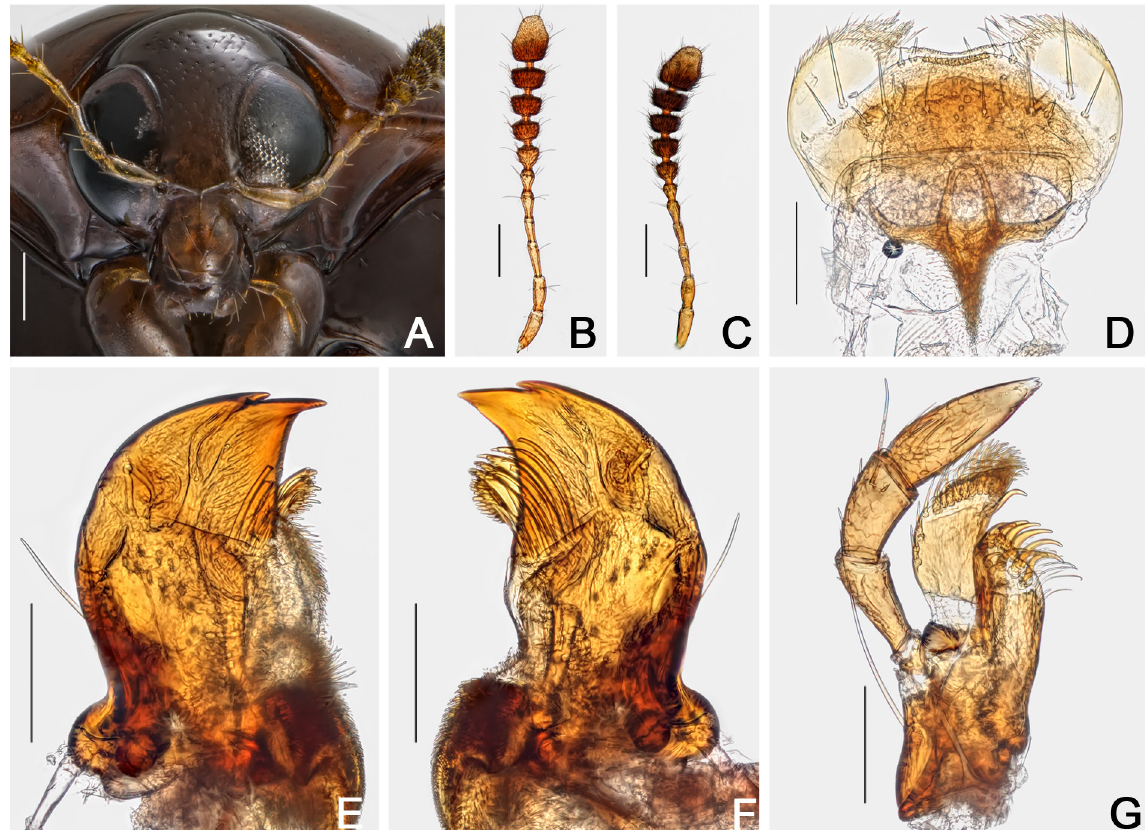
Fig. 48. Cyparium collare Pic, 1920. A–B, D–G . ♂ (CELC). A . Frontal view. B . Male antenna. C . Female antenna (CELC). D . Labrum. E . Left mandible. F . Rigth mandible. G . Maxilla. Specimens collected at Mata do Paraíso, Viçosa (MG, Brazil). Scale bars: A–C = 0.2 mm; D–G = 0.1